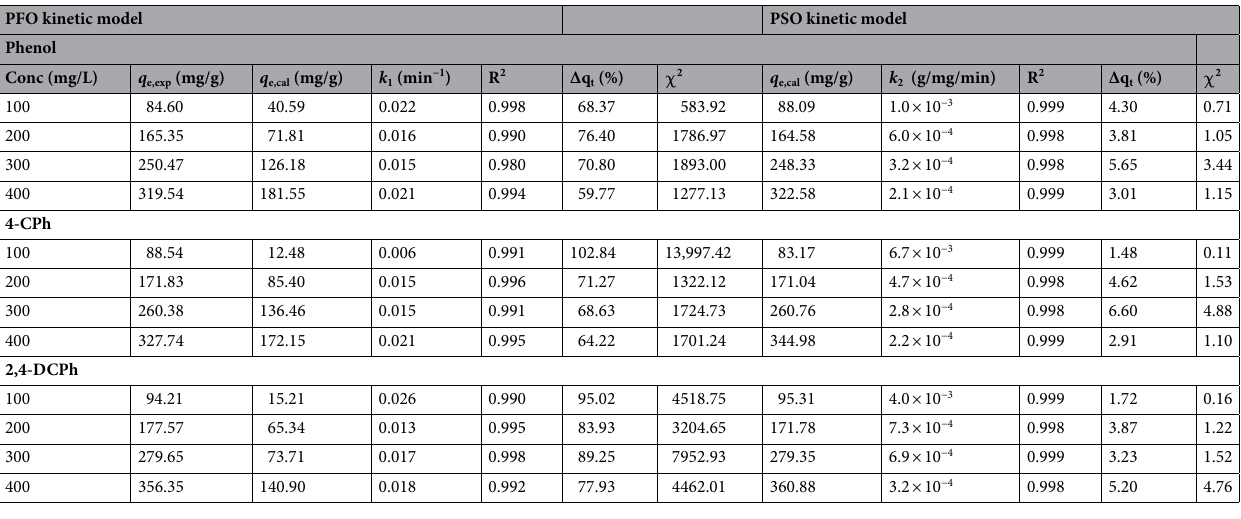
Table 2. PFO and PSO kinetic parameters of phenol, 4-CPh and 2,4-DCPh on